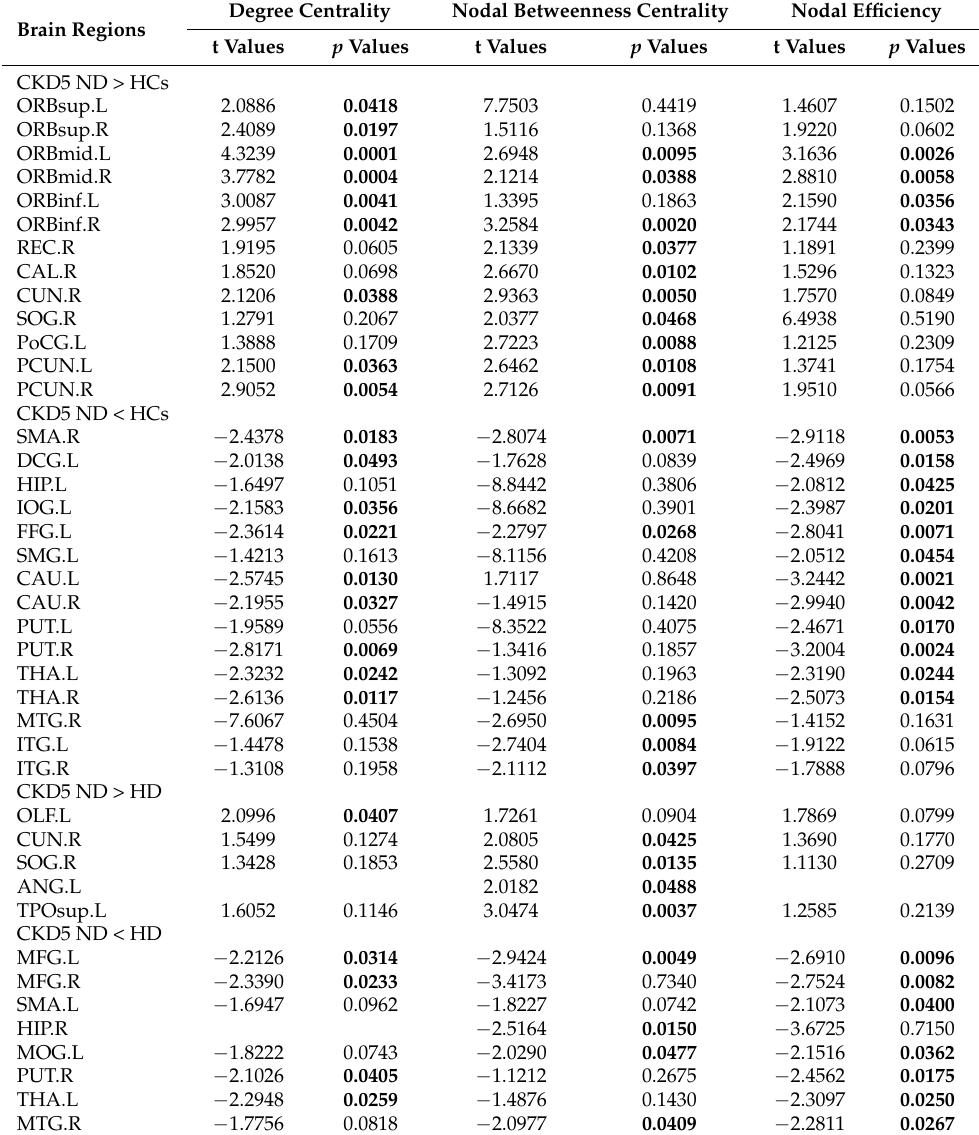
Table 2. The abnormal node network characteristics displayed by pairwise comparison between the CKD5 ND, HD, and HC